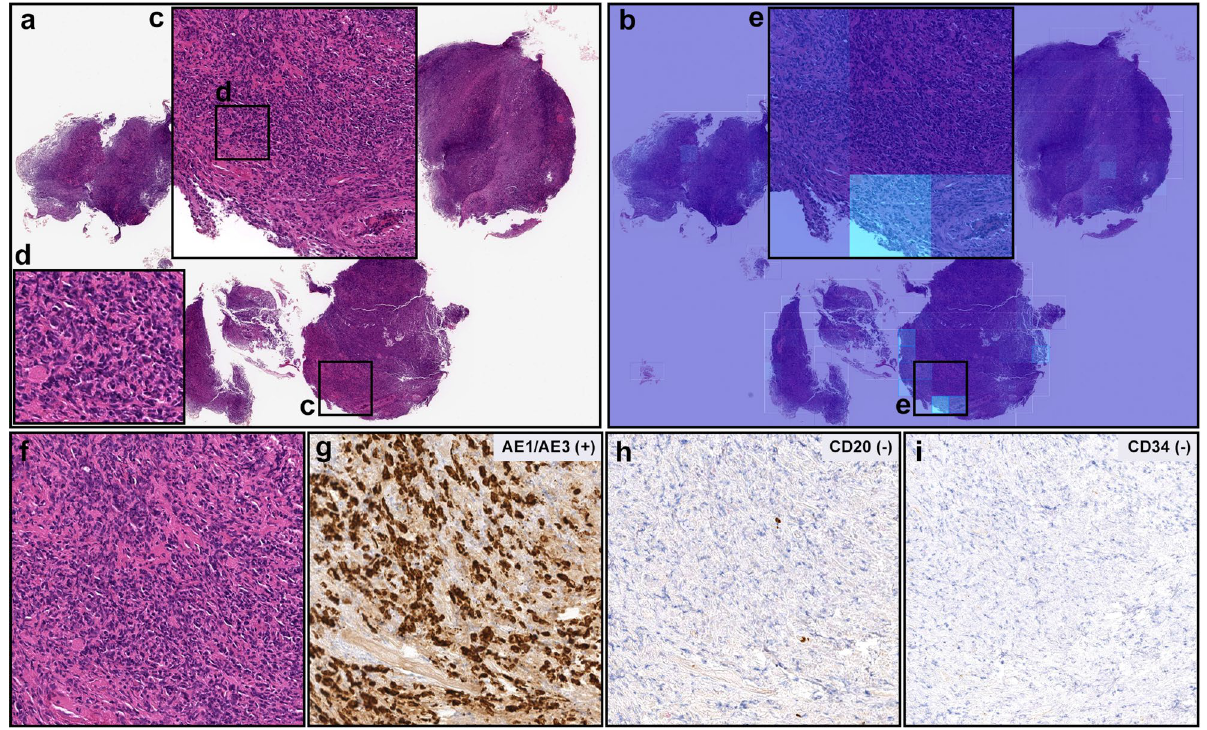
Figure 5. A representative false negative case. In ( a ), there are numerous number of infiltrating degenerative cancer cells ( c , d , f ) which were not predicted as diffuse-type ADC cells on heatmap image ( b , e ) in necrotic and granulation tissues. After immunohistochemical stainings with AE1/AE3 ( g ), CD20 ( h ), and CD34 ( i ), infiltrating cancer cells ( f ) exhibited AE1/AE3 positive, CD20 negative, and CD34 negative, indicating cancer of epithelial origin (carcinoma). Therefore, histopathologically, this case was diagnosed as a diffuse-type differentiated ADC. Model applied at × 20, where the 224 × 224px heatmap square represents 112 × 112 µ m